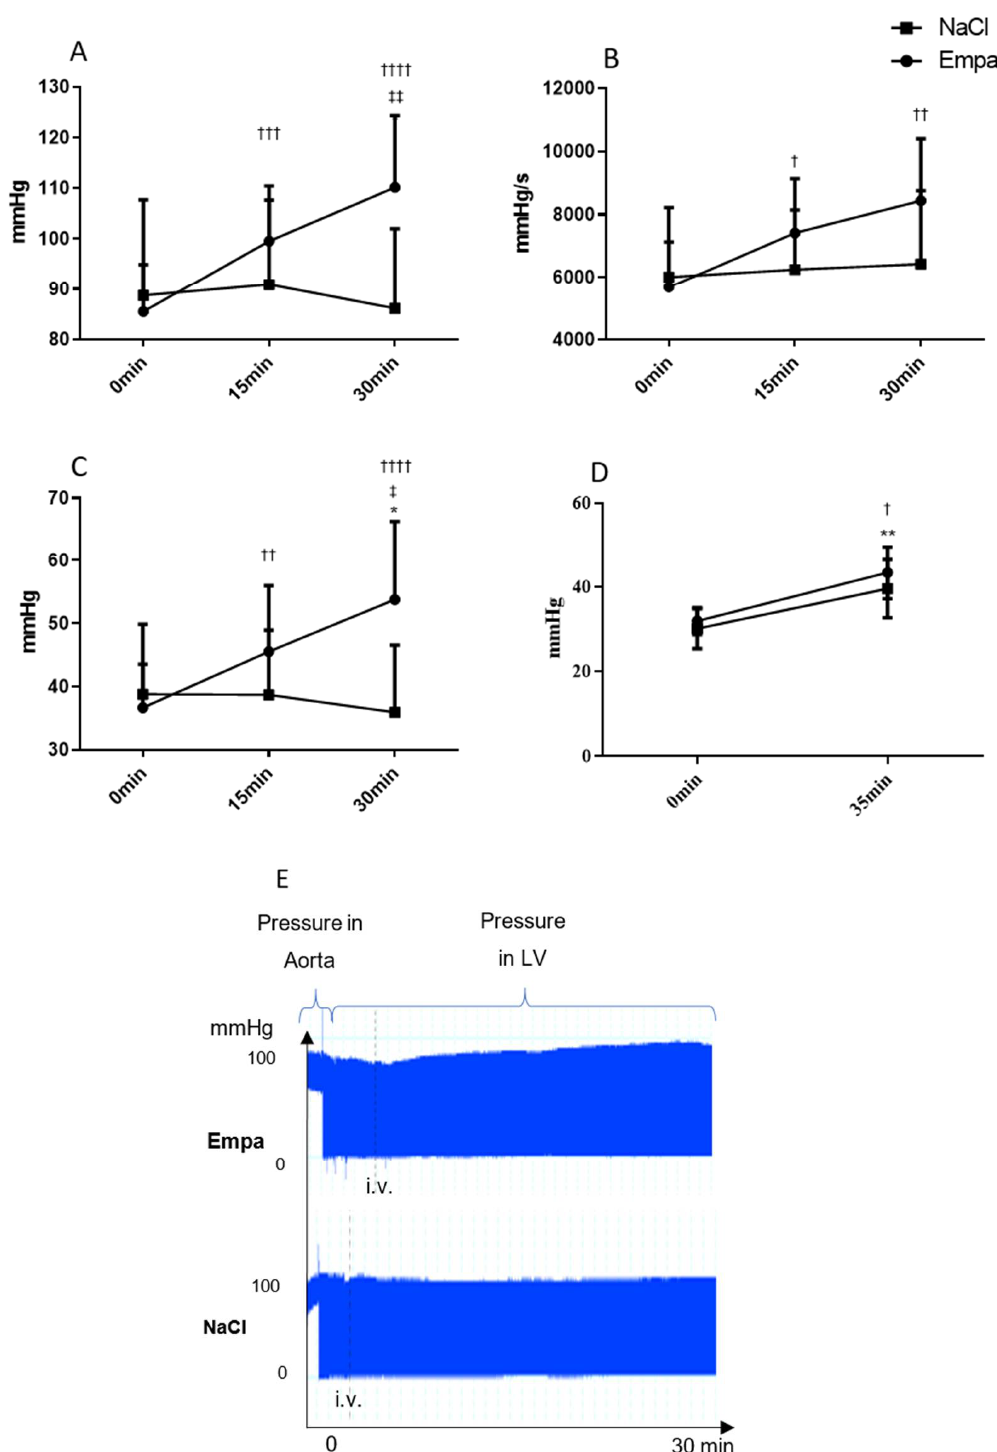
Figure 1. Hemodynamic parameters measured in the left ventricle by a cardiac catheter at baseline (0 min), 15 min, and 30 min after injecting NaCl or empagliflozin (Empa) (1 mg/kg/bw). Pressure mmHg ( x -axis) at different time of measurements ( y -axis). ( A ) Left ventricular maximal pressure (max pressure), * P < 0.05 Empa vs. NaCl 30 min; ††† P < 0.001, †††† P < 0.0001 vs. 0 min Empa, ‡‡ P < 0.01 vs. 15 min Empa. ( B ) Maximal rate of rise of left ventricular pressure (max dP/dt); † P < 0.05, †† P < 0.1 vs. 0 min Empa. ( C ) Mean Pressure; * P < 0.05 Empa 30 min vs. NaCl 30 min, †† P < 0.01, †††† P < 0.0001 vs. 0 min Empa, ‡ P < 0.05 vs. 15 min Empa. ( D ). Pulse pressure † P < 0.05, vs. 0 min Empa; ** P < 0.05 vs. 0 min NaCl. ( E ) Aortal and left ventricular pressure traces after Empa or NaCl administration, mean ± SD.